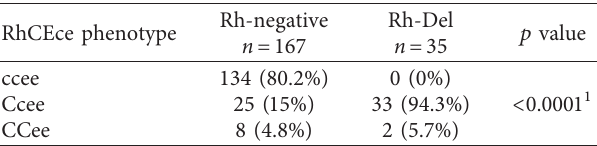
Table 2: Association of RhD phenotypes among RhCEce phe- notype ( N �